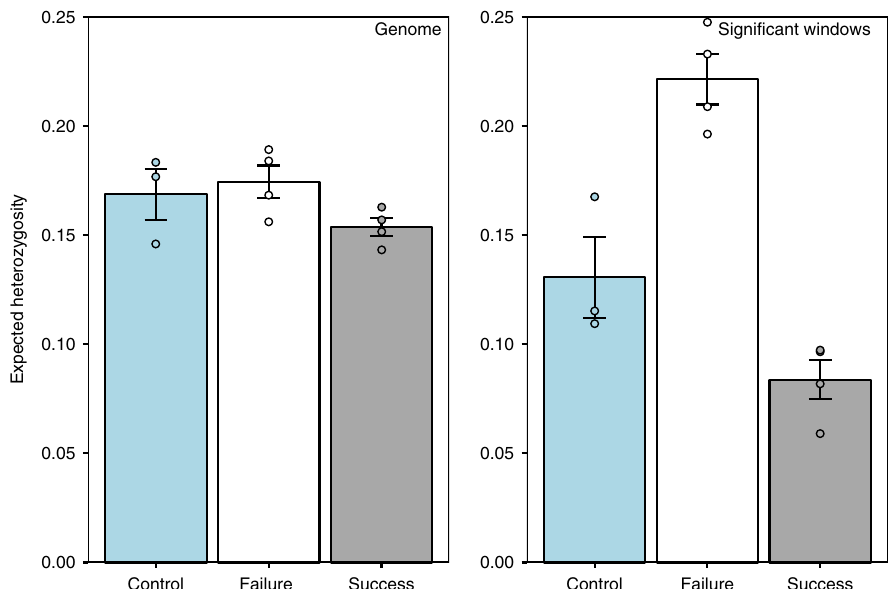
Fig. 2 Expected heterozygosity ( H e ) for each selection regimen. H e was calculated in 50 kb sliding windows with 10 kb step sizes and was calculated across all sliding windows (genome; left) and in windows with two or more signi fi cantly diverged variants (signi fi cant windows; right). Bars represent the mean ( ± SE) H e of the line medians (depicted as circles) for each regimen. Control lines are blue, failure-selected lines are white, and success-selected lines are grey. Source data are provided as a Source Data fi